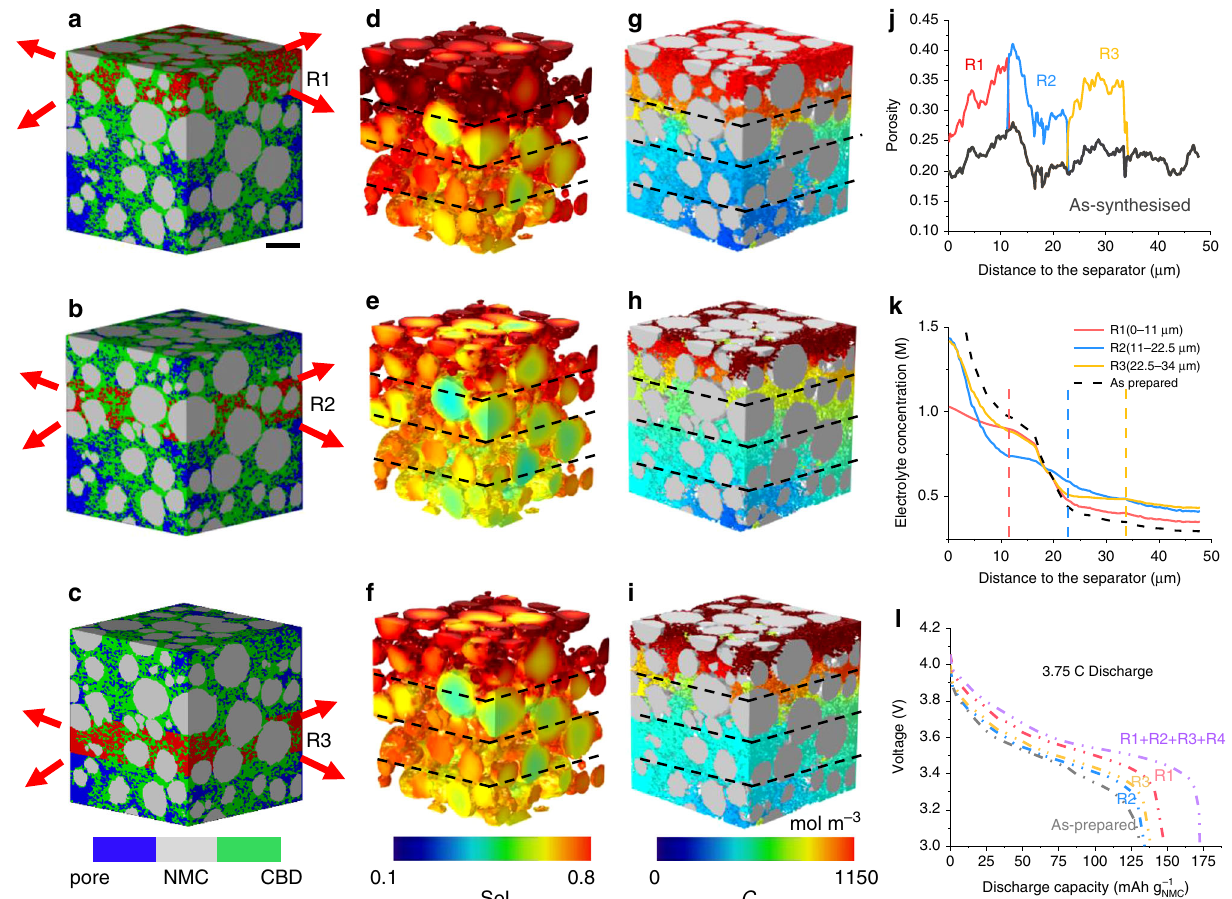
Fig. 7 Investigation of LiB electrode design with graded-porosity/pore size. Pore microstructure is enlarged locally by 250 nm: a 11 μ m (R1), b 22.5 μ m (R2), and c 34 μ m (R3) away from the separator. The processed regions are highlighted in red; d − f maximum accessible SoL comparison between the three samples (84%, 77% and 76% DoD) discharged at 3.75 C, with the dashed lines (also those in ( k )) representing the boundaries of the three processed zones; g − i the corresponding distribution of electrolyte concentration; j plot of porosity vs. electrode thickness for the three samples, labelled as R1, R2 and R3, with the grey curve representing the baseline for the as-prepared sample; k local concentration gradient suppressed by the enlarged pores in each region at 50% DoD; l comparison of electrochemical performance for different microstructural designs. R1 + R2 + R3 + R4 refers to global dilation of the pore microstructure. The scale bar in ( a ) represents 10 μ